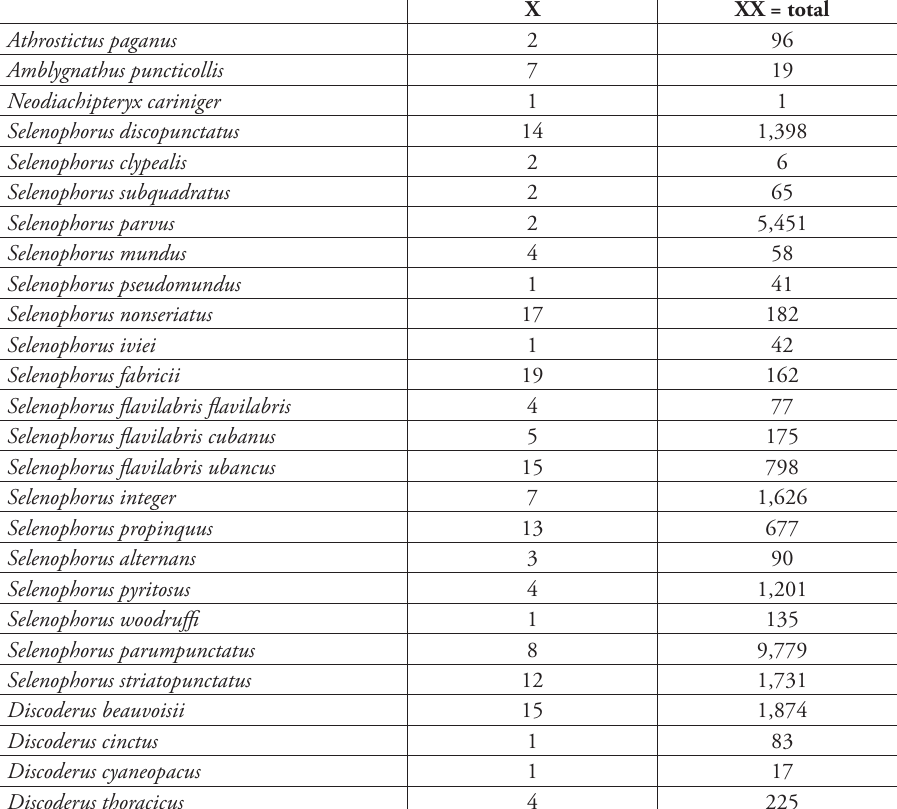
Table 3. Number of specimens of Selenophori species in West Indies with habitats or collection methods or elevations known, and total number of specimens per species.